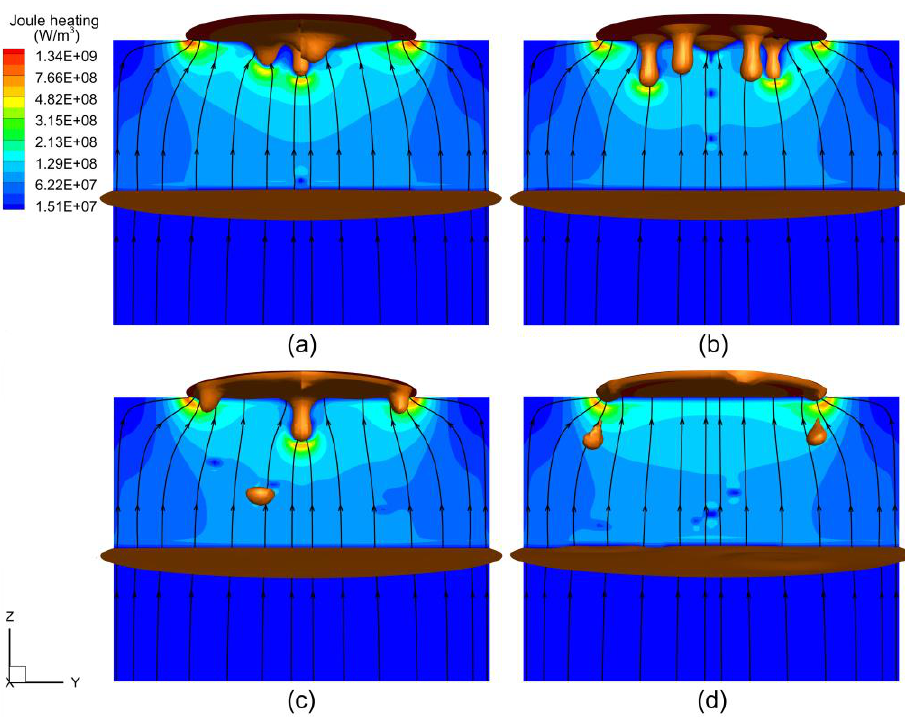
Figure 4. Predicted distributions of Joule heating density and current paths in the mold with the electrode rotating at different speeds: ( a ) 0; ( b ) 20 rpm; ( c ) 40 rpm; ( d ) 60 rpm. The current mesh height is 150 mm.